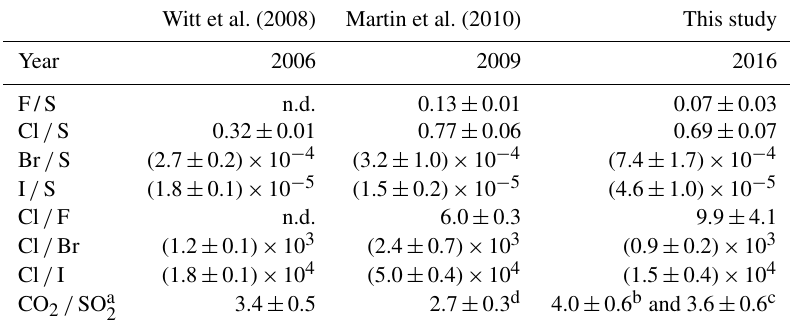
Table 5. Halogen/sulfur and inter-halogen ratios of Masaya’s gas emissions between 2006 and 2016. “n.d.” denotes not detected.